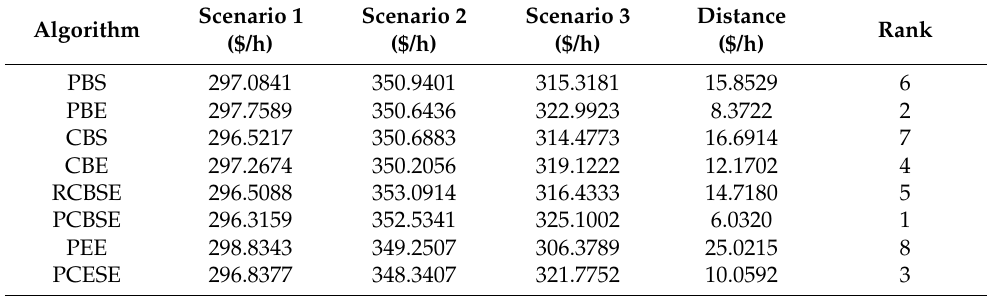
Table 5. The comparison of the